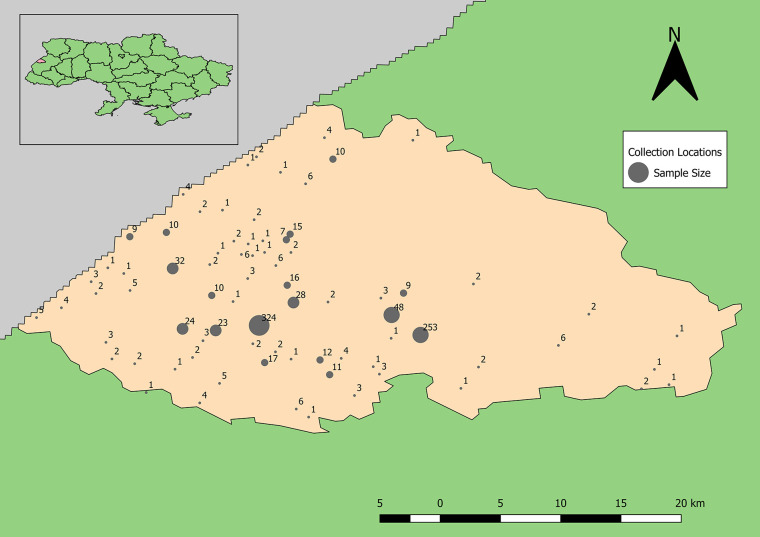
Distribution of human sera samples collected and tested for antibodies to Old World hantaviruses and CCHFV by unique location (towns and villages of subject’s residence).